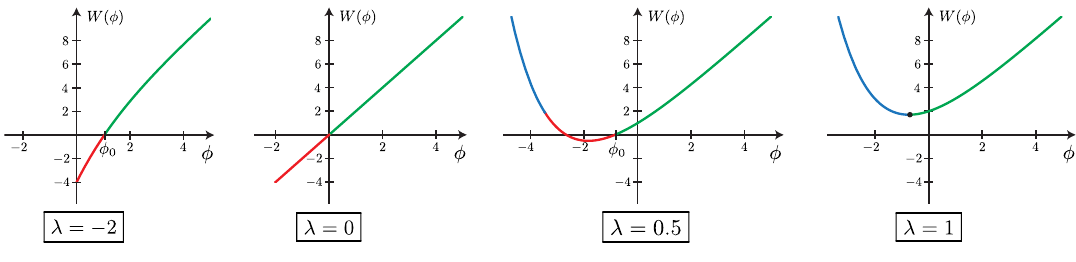
Figure 8. Deformed JT gravity dilaton potential W ( φ ) = 2 φ + U ( φ ) in (4.1) for α = 0 . 9 ∼ 1 and several values of λ . Black hole solutions exist for φ = φ h indicated in green (stable) and blue (unstable). For λ > λ c in (4.2) there is a transition to a regime in which there are no zero temperature black hole